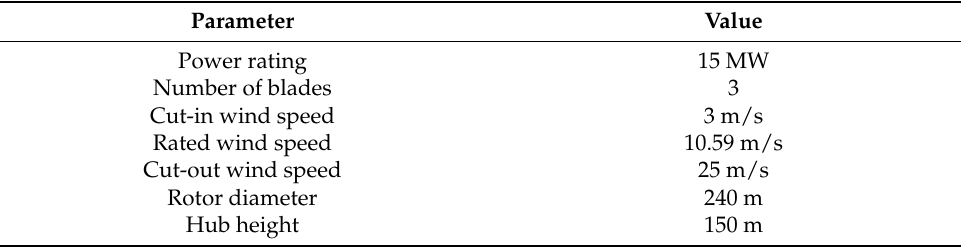
Figure 1. Airfoil data for the blades. Table 1. Parameters of the 15 MW reference wind turbine.